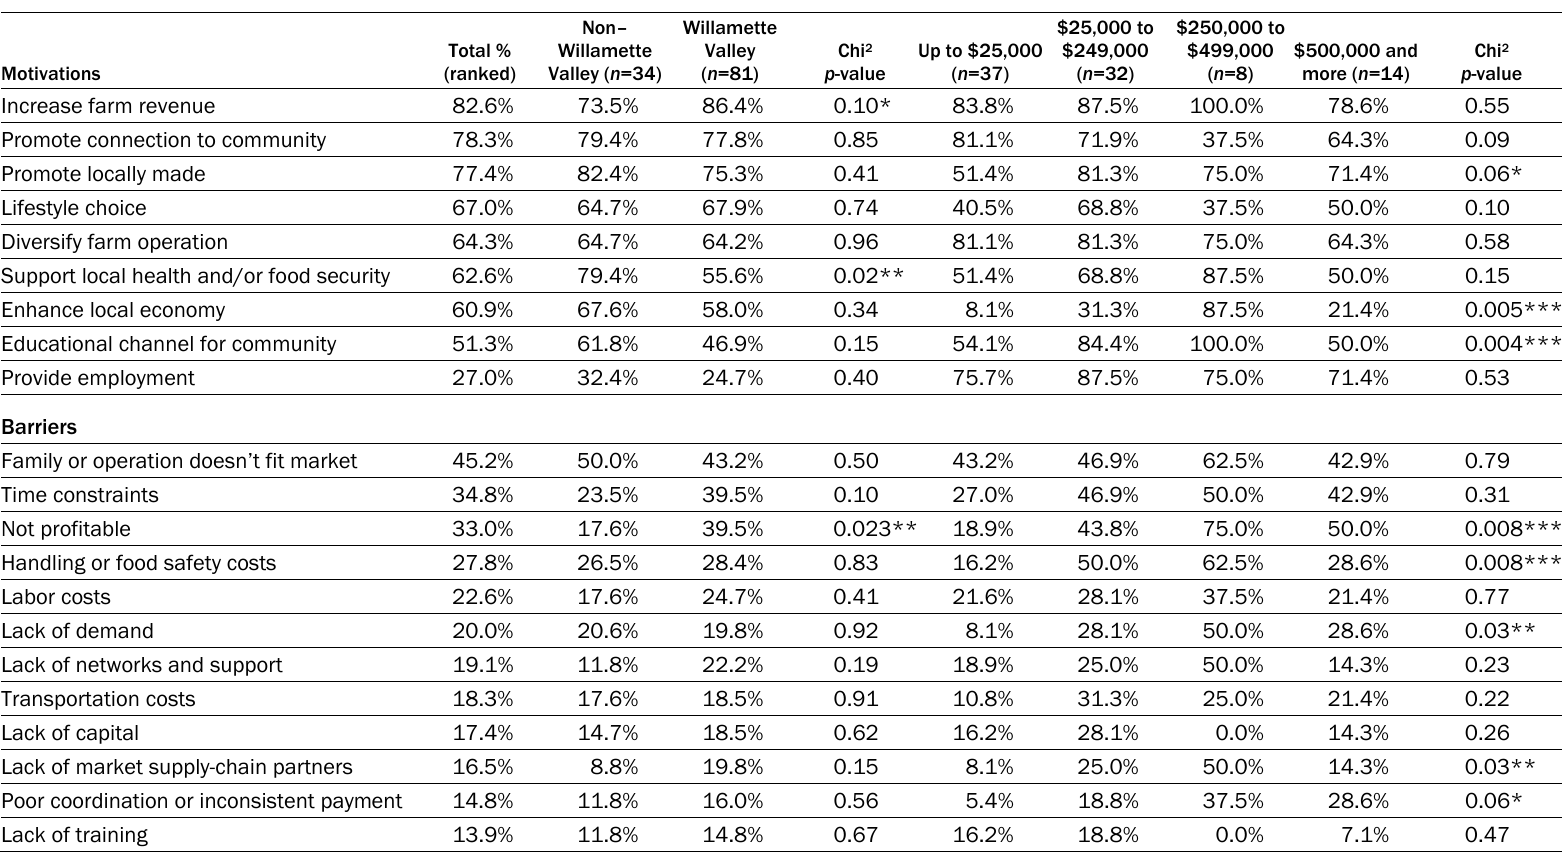
Table A2. Motivations and Barriers to Local and Regional Marketing by Region and Gross Farm Income (in US$)